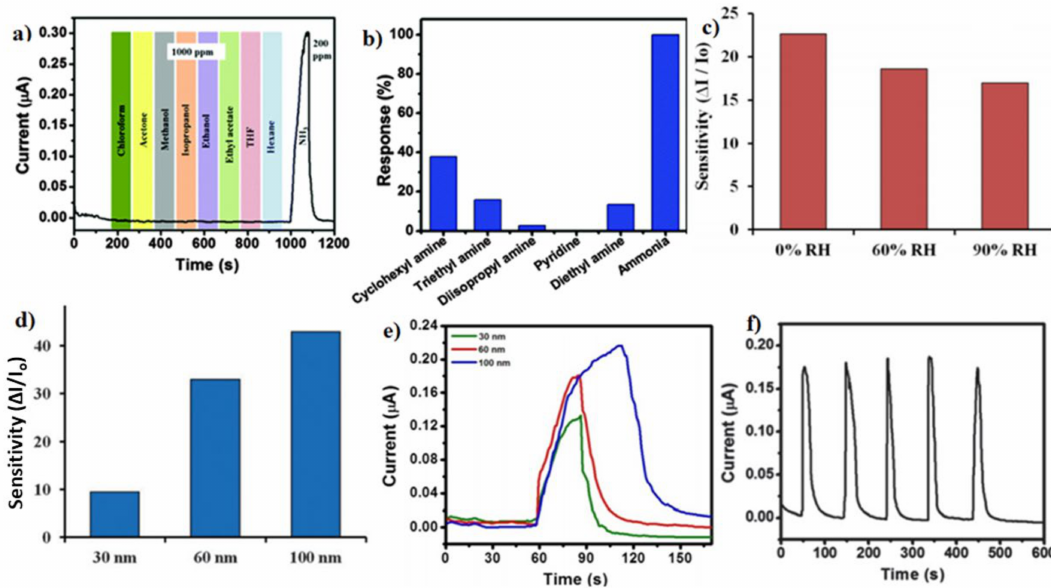
Figure 13. Response of a PDI-HIS sensor towards vapor of various common types of ( a ) organic solvents and ( b ) amines. Concentrations of ammonia and other analytes used were 200 and 1000 ppm, respectively. ( c ) Sensitivity of PDI-HIS at 0%, 60%, and 90% relative humidity levels. ( d ) Effect of film thickness on sensitivity of the sensor. ( e ) Current–time response observed in three devices with different film thicknesses upon exposure to 100 ppm of ammonia. ( f ) Recyclability study with 100 ppm of ammonia. Adapted with permission